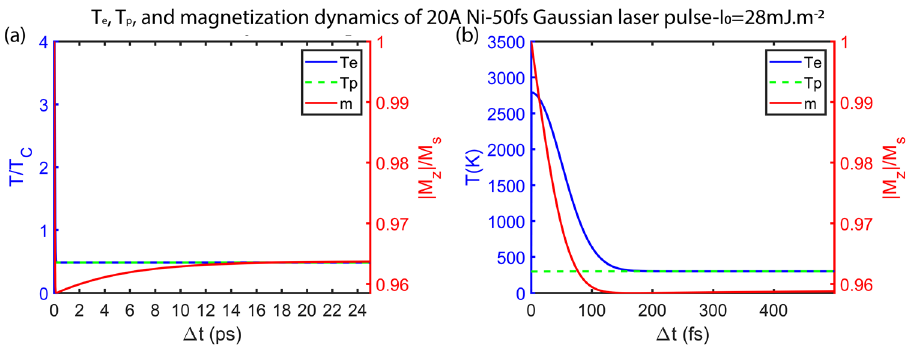
Figure 3. ( a ) Transient T e , T p , and normalized magnetization (m =|M z |/M s ) for 20 Å thick Ni film illuminated with I 0 = 28 mJ m −2 Gaussian single laser pulse of 50 fs width. ( b ) Zoomed-in version of ( a ) 500 fs after illumination. Note that the Y-axis units are different in ( a ) and ( b